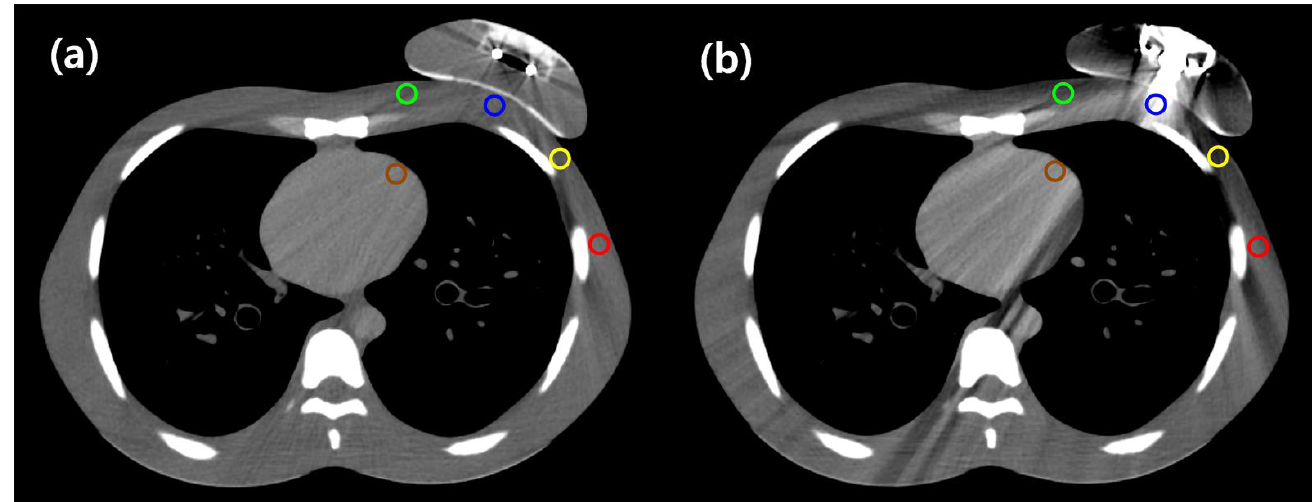
Figure 3. An example of the CT image ( a ) RFID port, ( b ) metallic port analysis using the five reference points; point A - central chest wall (blue), point B - medial chest wall (green), point C – lateral chest wall (yellow), point D – axilla (red), point E - left anterior descending artery (brown).